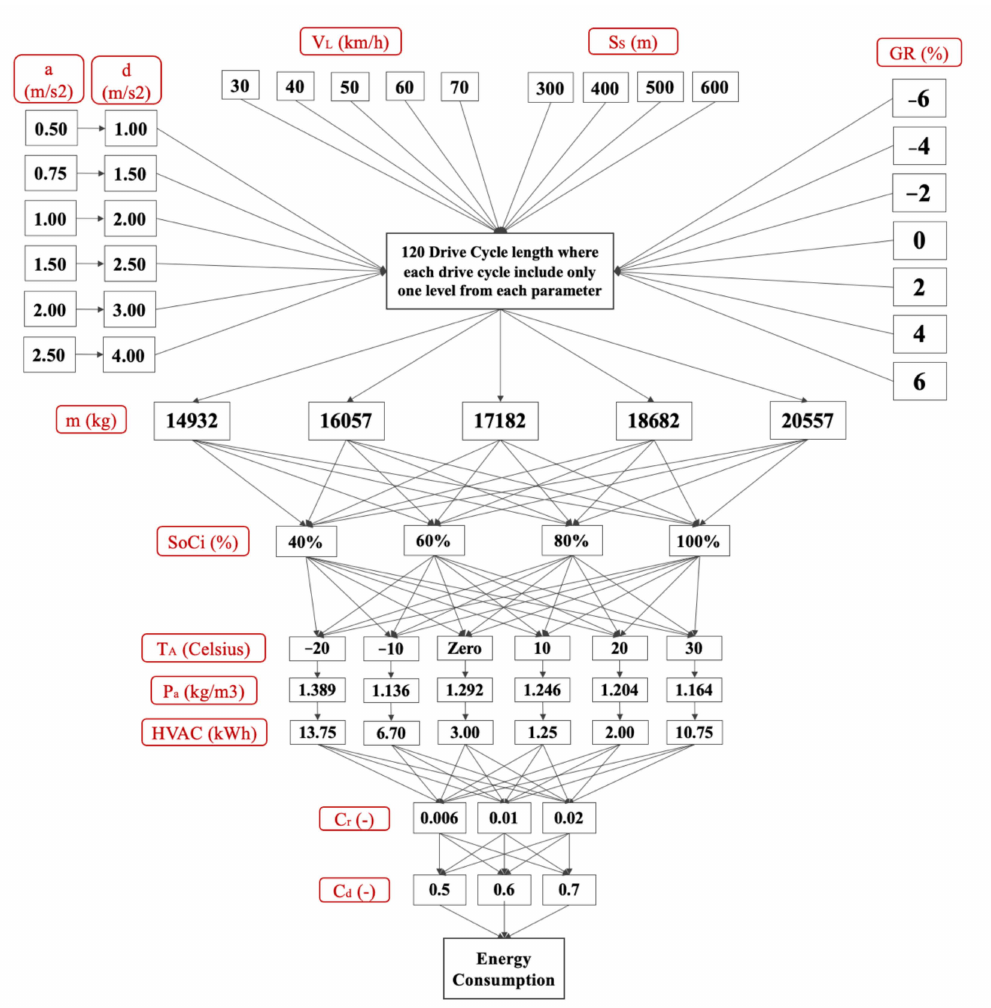
Figure 6. Full-factorial experimental design parameters (907,199